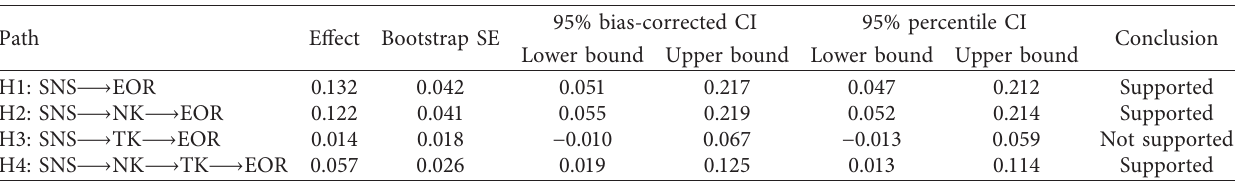
Figure 2: Structural equation model with results. Note. Coefficients are unstandardized coefficients. Nonsignificant paths are represented by dotted lines. ∗∗∗ p < 0 . 001, ∗∗ p < 0 . 01, and ∗ p < 0 . 05 (two-tailed). Table 5: Results of hypothesis